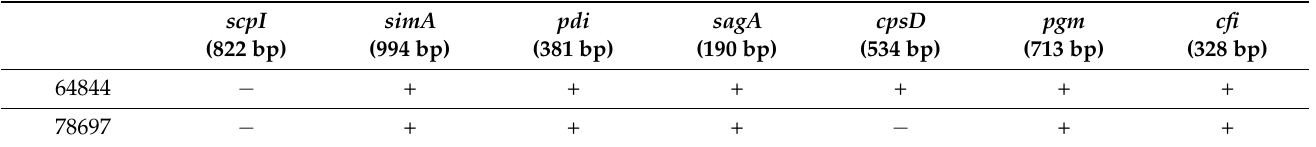
Table 3. Results obtained for the virulence factors amplification and their specific